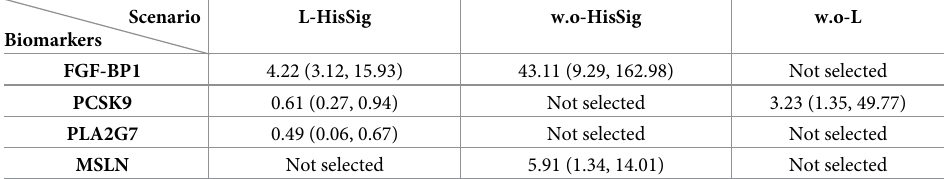
Table 1. The estimated odds ratios of FGF-BP1, PCSK9, PLA2G7, and MSLN via linear base-learners in each scenario.